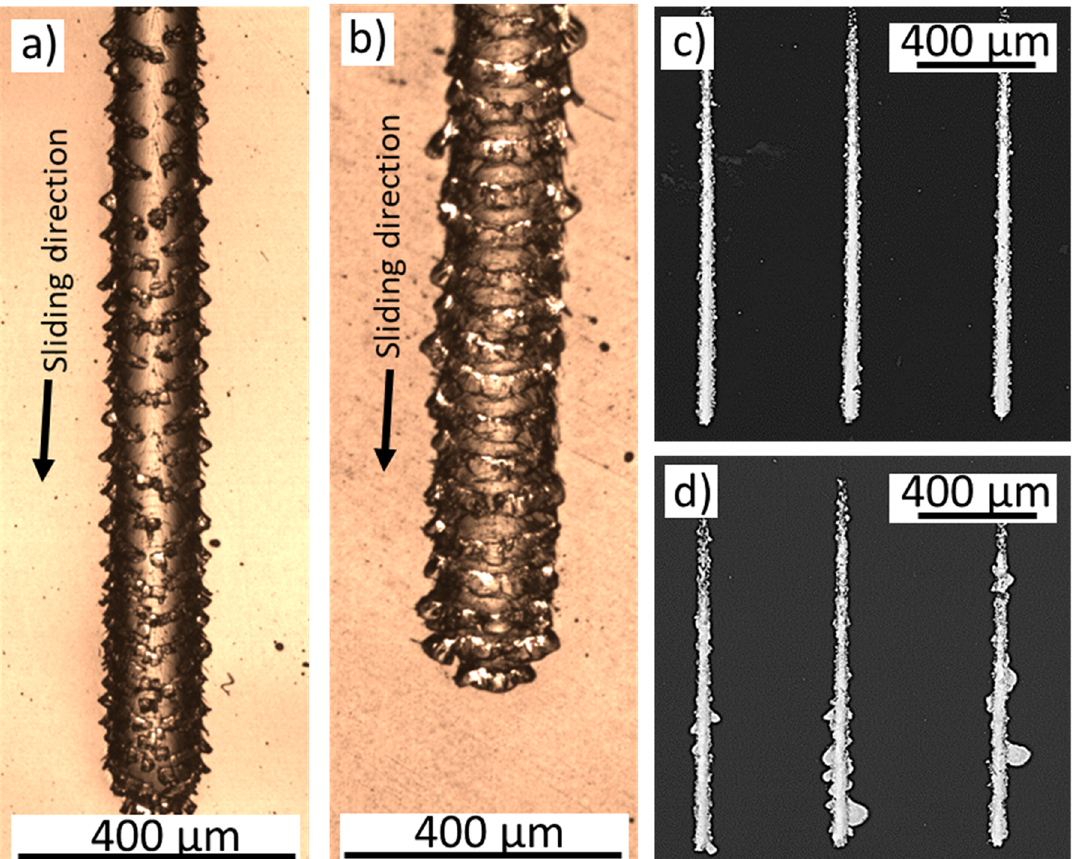
Figure 10. Image taken from the end of the scratch, showing that the DLC film was not removed under an applied load of 80 N. Small spallation regions can be seen propagating from the borders of the scratch, forming ~45º with the sliding direction. a, c) DLC-1 and b, d)